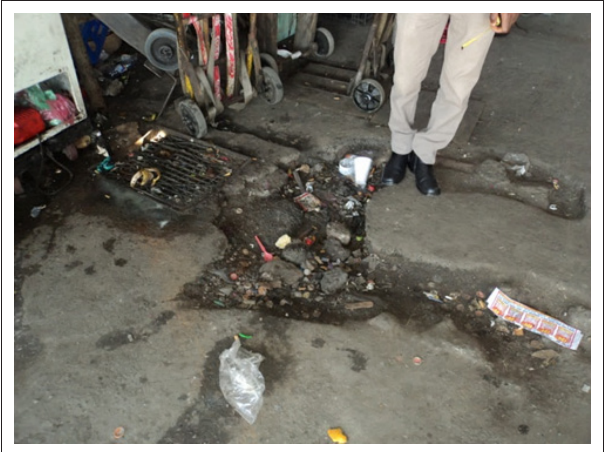
FIGURE 4: Pothole (120 mm deep and 530 mm